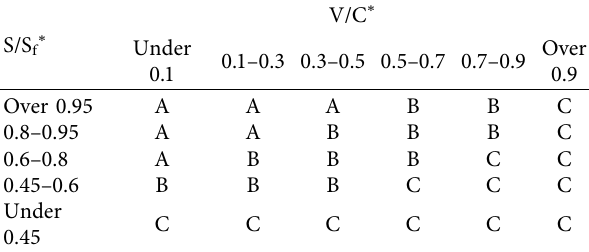
Table 1: Determining hourly traffic state.